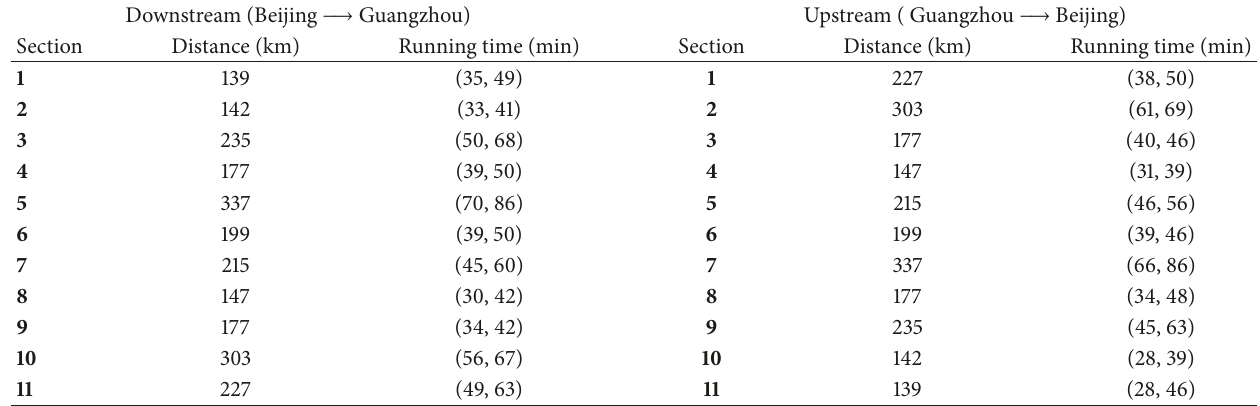
Table 3: Information of distance and running time on the high-speed railway.